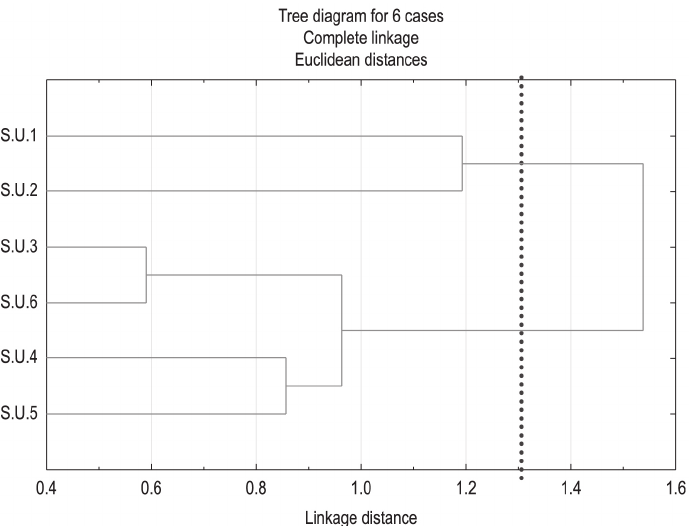
Figure 3. Dendrogram of cluster analysis based on six abiotic variables (pH-value, water temperature, electrical conductivity, turbidity, salinity and dissolved oxygen) and the eleven taxa of macroinvertebrates sampled in six sampling units